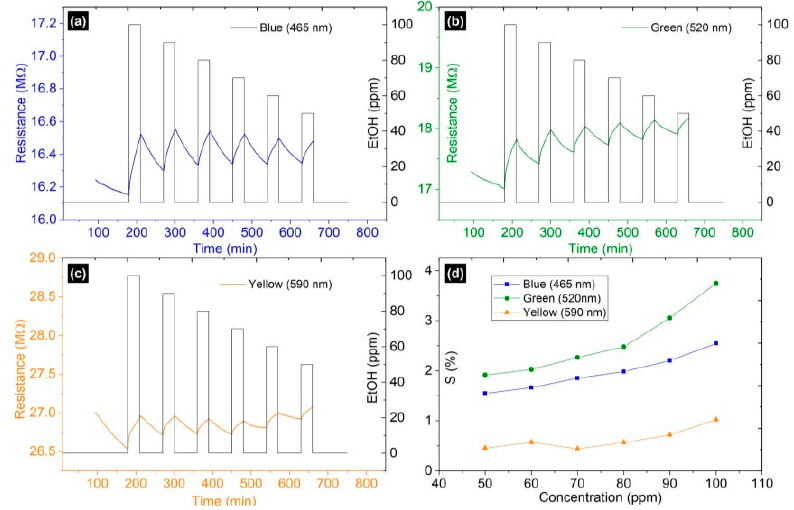
Figure 2. CaFe 2 O 4 sensor responses in varied ethanol vapor concentrations (i.e., 50–100 ppm) under activation of ( a ) blue (465 nm), ( b ) green (520 nm), and ( c ) yellow (590 nm) LEDs. ( d ) Comparison of the sensor sensitivity under different light